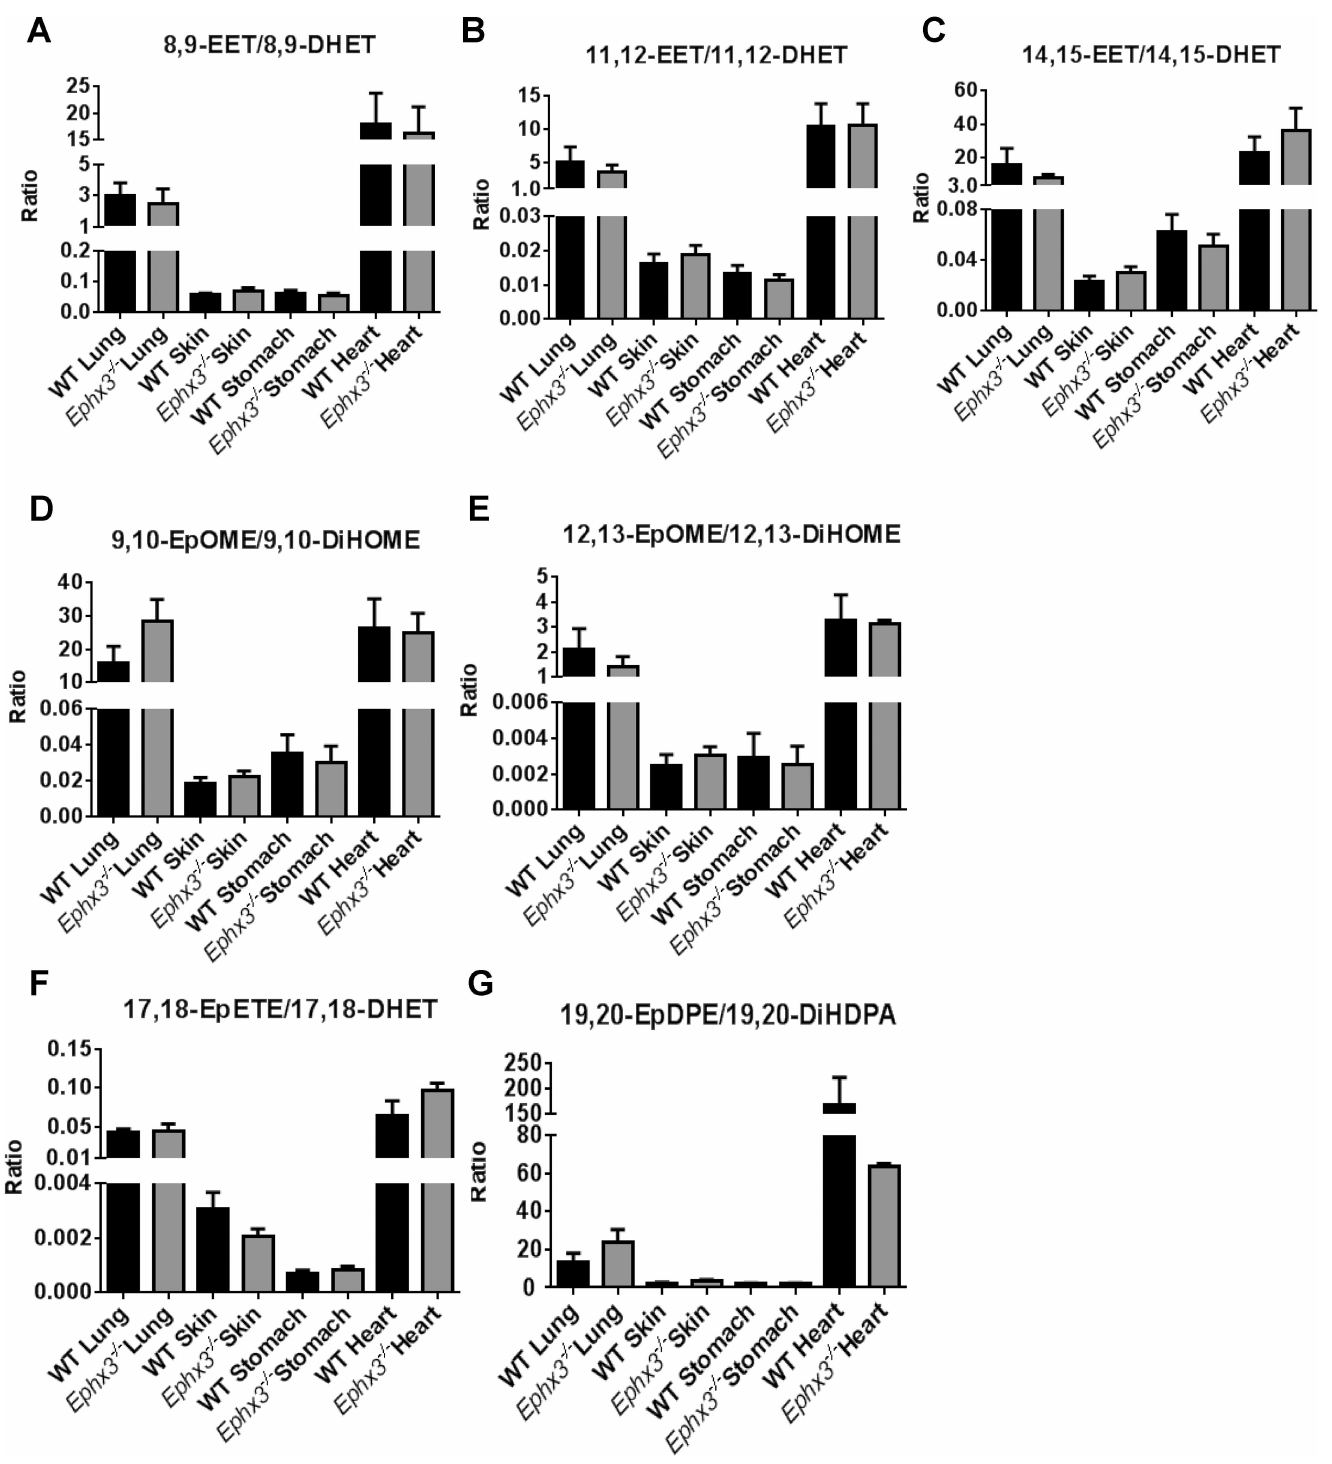
Fig 5. LC-MS/MS analysis shows no differences in endogenous epoxide:diol ratios in the Ephx3 -/- mice. Endogenousepoxide:diolratios for (A) 8,9-EET/8,9-DHET, (B) 11,12-EET/11,12-DHET, (C) 14,15-EET/14,15-DHET, (D) 9,10-EpOME/9,10-DiHOME, (E) 12,13-EpOME/12,13-DiHOME, (F) 17,18-EpETE/17,18-DHET, and (G) 19,20-EpDPE/19,20-DiHDPA were determined in the heart, lung, skin, and plasma by LC-MS/MS in Ephx3 -/- and WT mice (n = 3–10, p = NS).